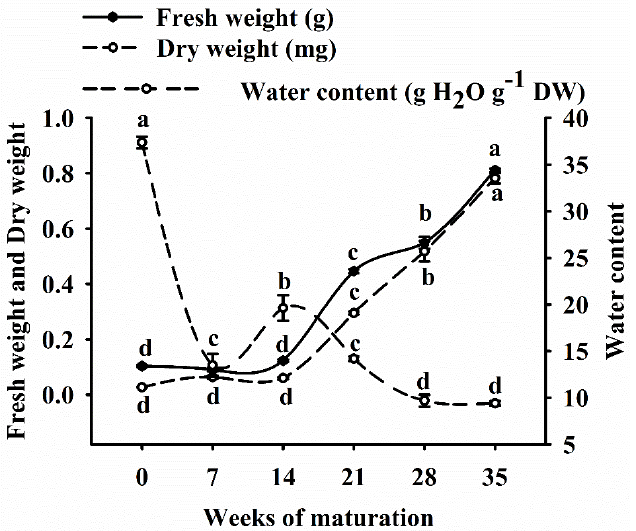
Figure 4. Changes in fresh weight, dry weight and water content of the Korean pine somatic embryos during maturation. Different letters above the curve indicate significant differences between samples. (Duncan test; P =0.05).